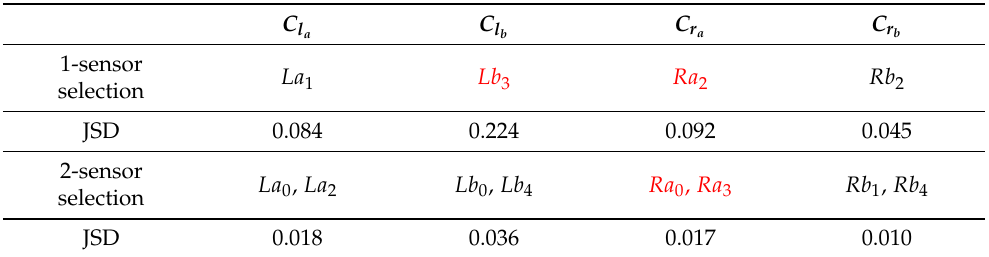
Table 2. JSD from the sensor removal results. The different choices between Tables 2 and 3 are marked in red.